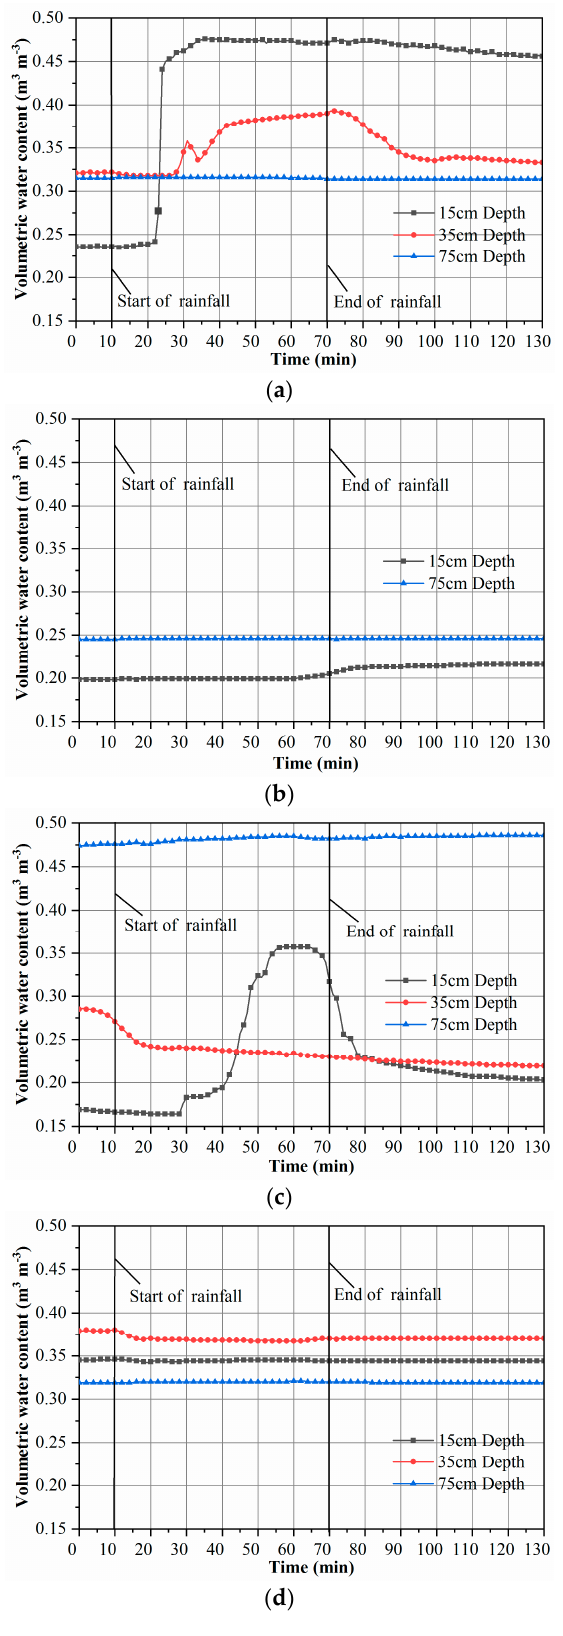
Figure 11. Response of volumetric water contents in the Dry run: ( a ) 70% slope; ( b ) 47% slope; ( c ) 32% slope; ( d ) 21% slope.